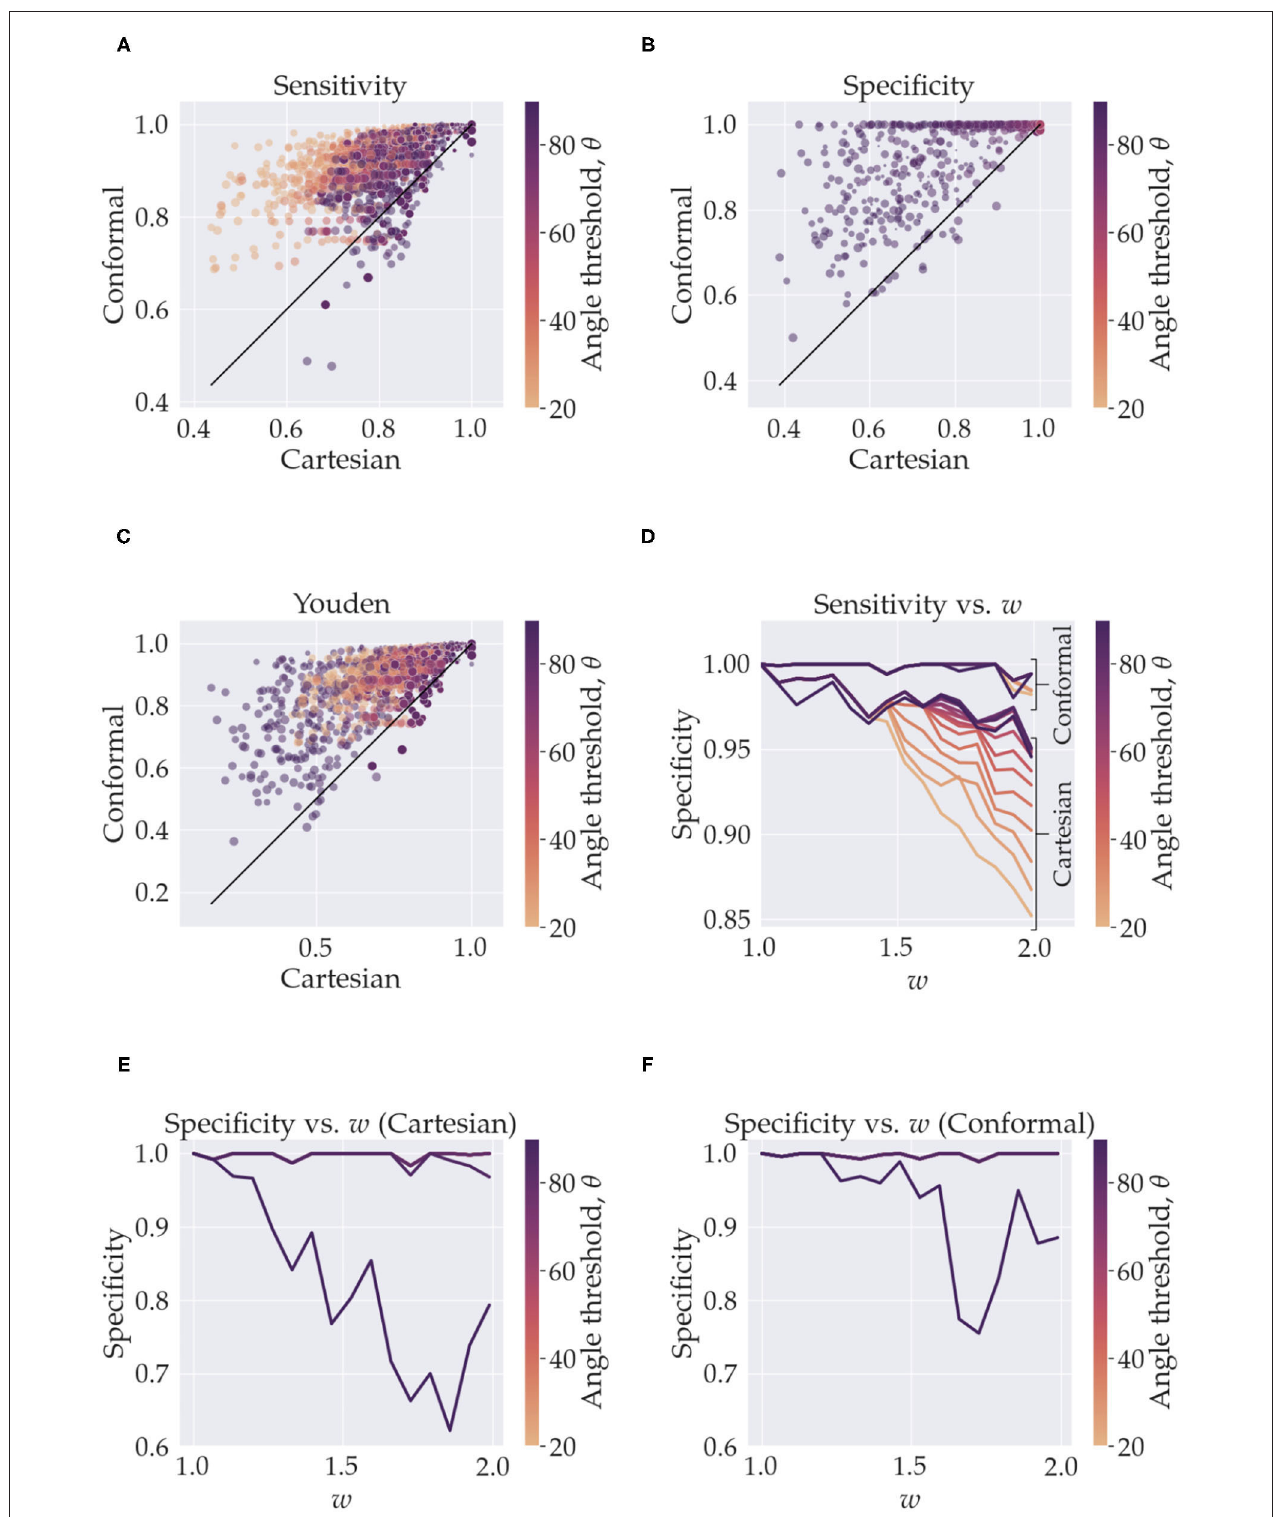
FIGURE 2 | This figure summarizes the sensitivity and specificity measurements from the simulations. In (A–C) , the y -axis represents quantities calculated with using conformal coordinates and the x -axis represents quantities calculated with using Cartesian coordinates. The results from the whole parameter space are shown, the color of the markers represents the angle threshold, where the orange is low angles and purple is high. The size of the markers depicts the resolution, small markers